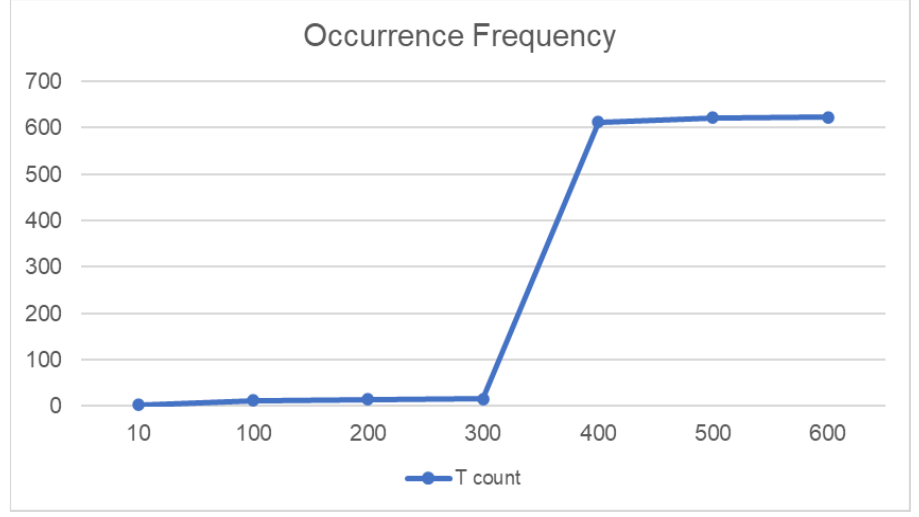
Figure 12. Occurrence frequency of the proposed